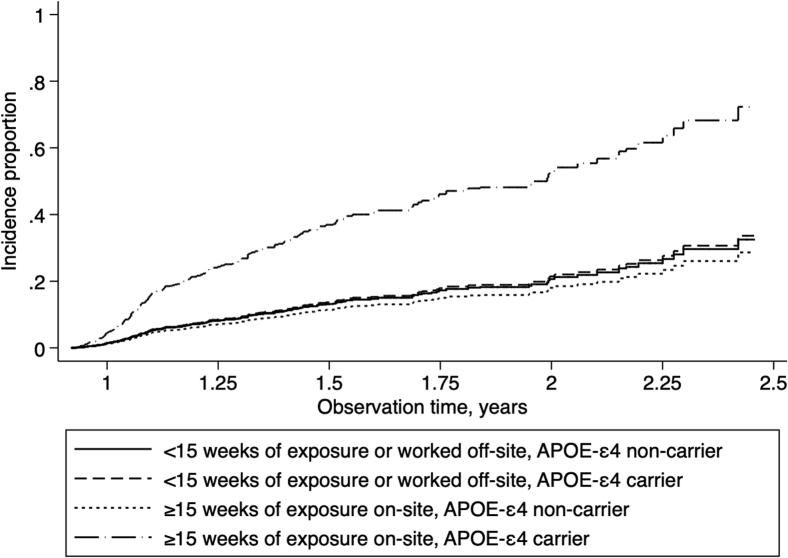
Cumulative incidence proportion showing incidence of mild cognitive impairment among responders, separated by WTC exposure severity and by APOE-ε4 allele possession status group. Abbreviation: WTC, World Trade Center.